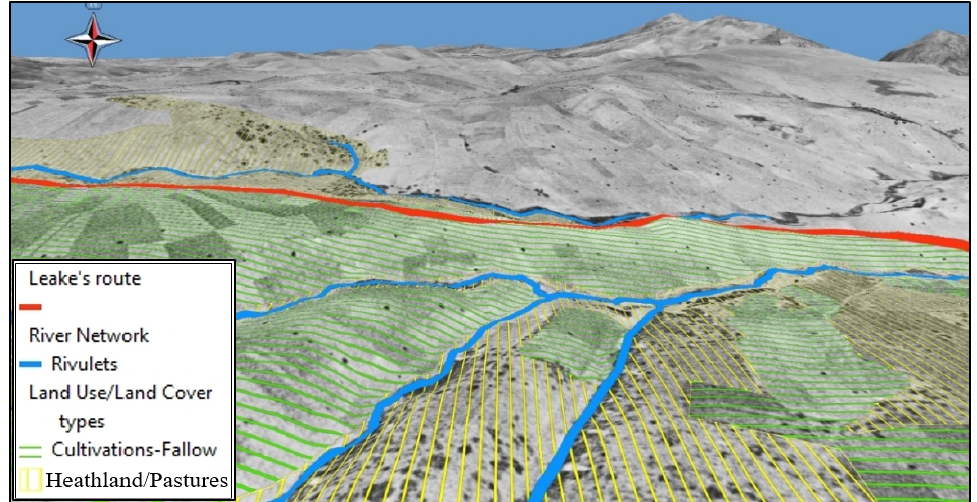
Figure 9. Depiction of the land cover mosaic (crops, pasture, and natural vegetation).